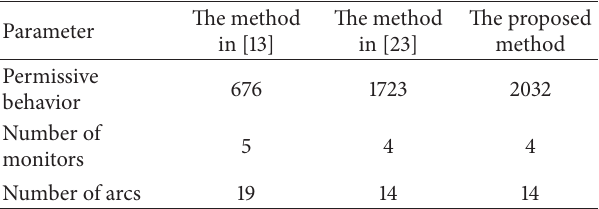
Table 2: The performance comparison of supervisors for the S 4 PR in Figure 1(a) due to different policies.